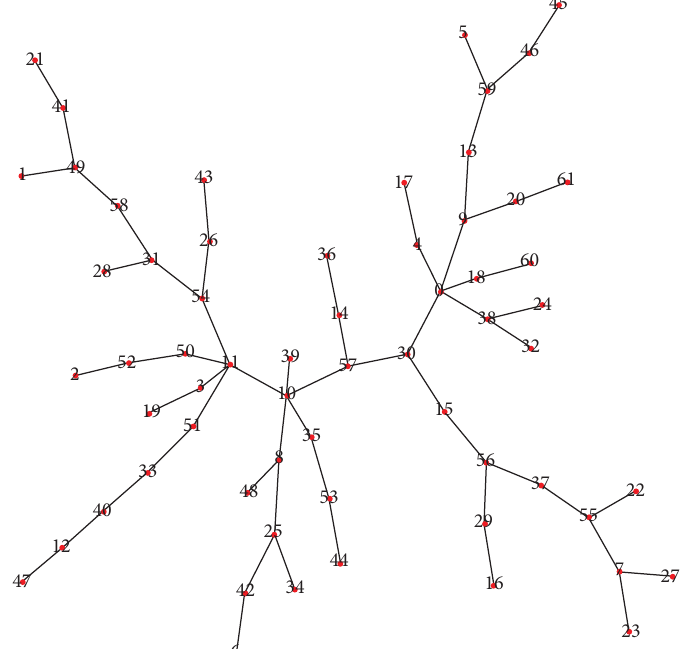
Figure 6: Energy stock jump complex network from April 2018 to October 2018.